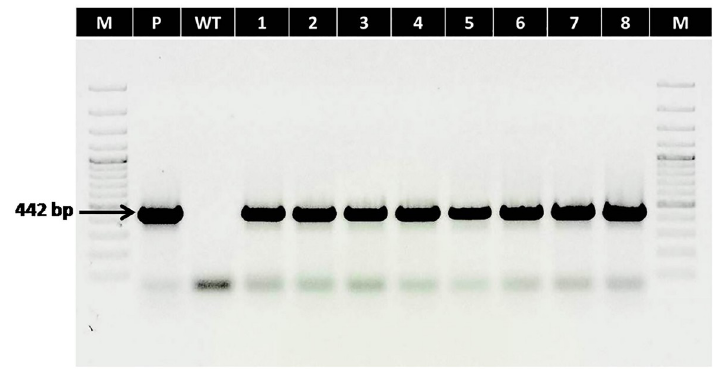
Fig 1. PCR screening of transgenic lines (T 3 ) using AtDREB1A transgene-specific primers with expected amplification size of 442 bp. Lanes–M: 100bp marker; P: Plasmid positive control (pCAMBIA2300 having AtDREB1A gene); WT: Non-transformed control; 1–8: Transgenic lines